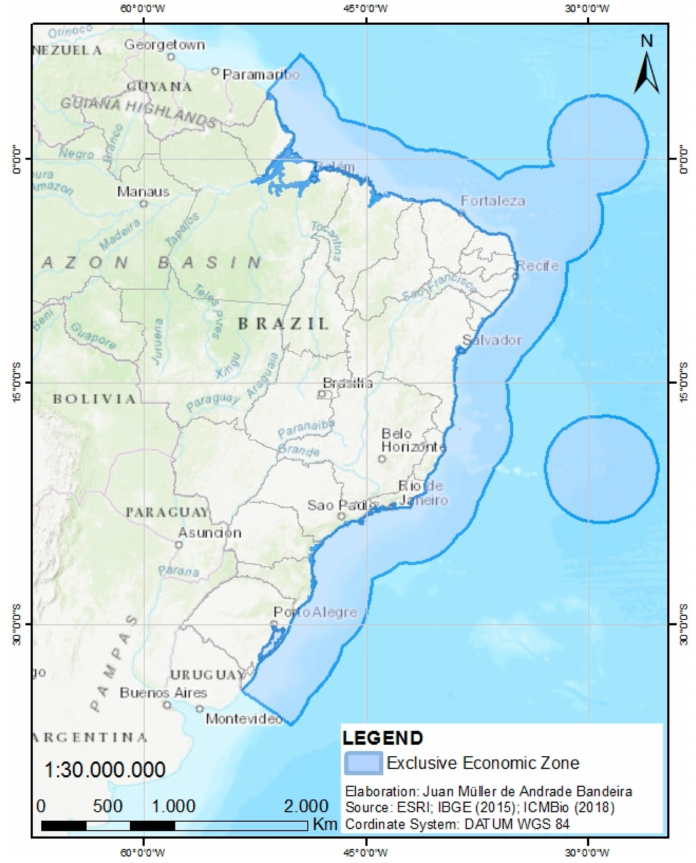
Figure 2. Delimitation of the Brazilian exclusive economic zone (EEZ). Source: